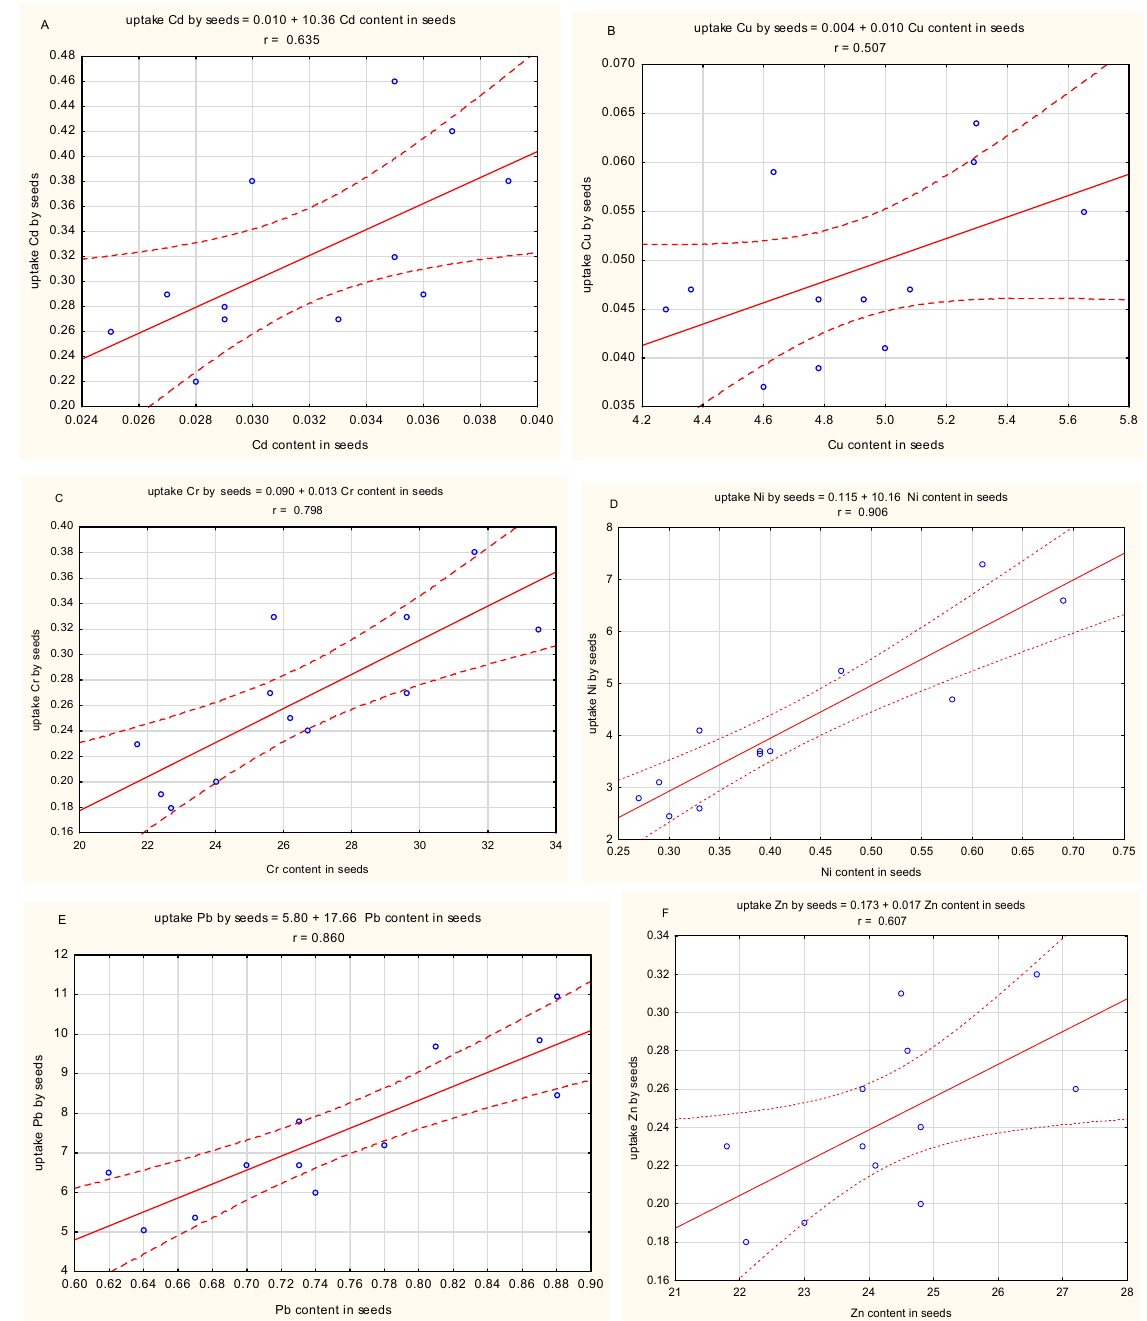
Figure 1. Rectilinear relationship between the content and uptake of heavy metals by rape seeds under the influence of applied fertilizer granulates in mg·kg − 1 DM/.